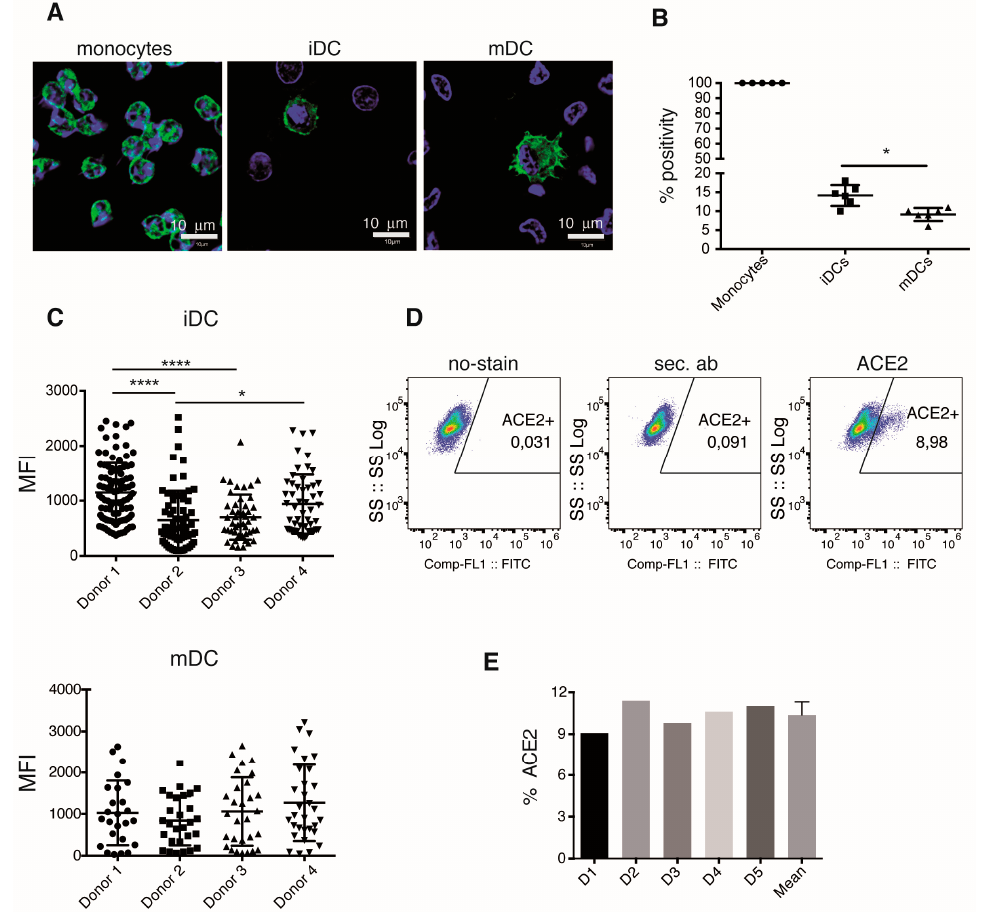
Figure 6. iDCs differentially express ACE2. Human monocytes, iDCs and mDCs, were fixed and analyzed by confocal microscopy to determine ACE2 expression. ( A ) ACE2 (green) and nucleus (blue) in confocal images of one representative experiment. ( B ) Percentage of ACE2 positive cells determined as ( A ) in different donors. ( C ) ACE2 inter-donor expression was evaluated in the ACE2 positive cells from different donors by analyses of MFI of Z stacks images. Comparison of ACE2 expression in iDCs (top) and mDCs (bottom). ( D ) ACE2 expression was determined in iDCs by flow cytometry. Representative plot of one experiment. Profile of unstained control cells (left), secondary ab (middle), and ACE2-stained cells (right). ( E ) Percentage of ACE2 positive iDCs per donor determined by flow cytometry. Statistical comparisons were performed by using One-way ANOVA test. Only significant differences are indicated. * p < 0.05, **** p < 0.006. In ( B ) and ( C ), n = 4, in E, n = 5